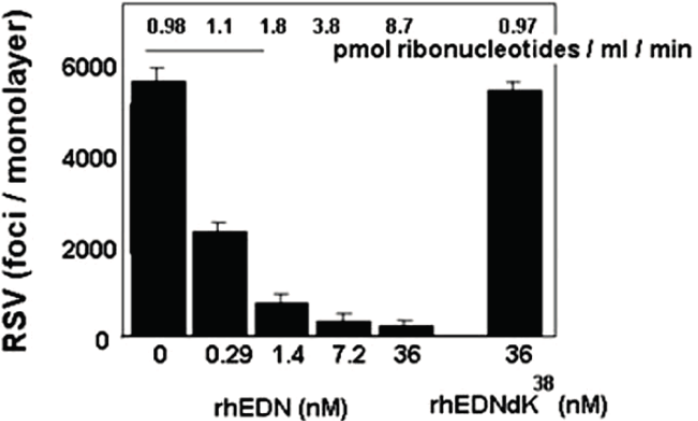
Figure 4. Recombinant human EDN limits the infectivity of the human RSV pathogen for target respiratory epithelial cells in vitro . Human EDN displays dose-dependent antiviral activity that is abolished when the protein is rendered catalytically inactive (rhEDNdK 38